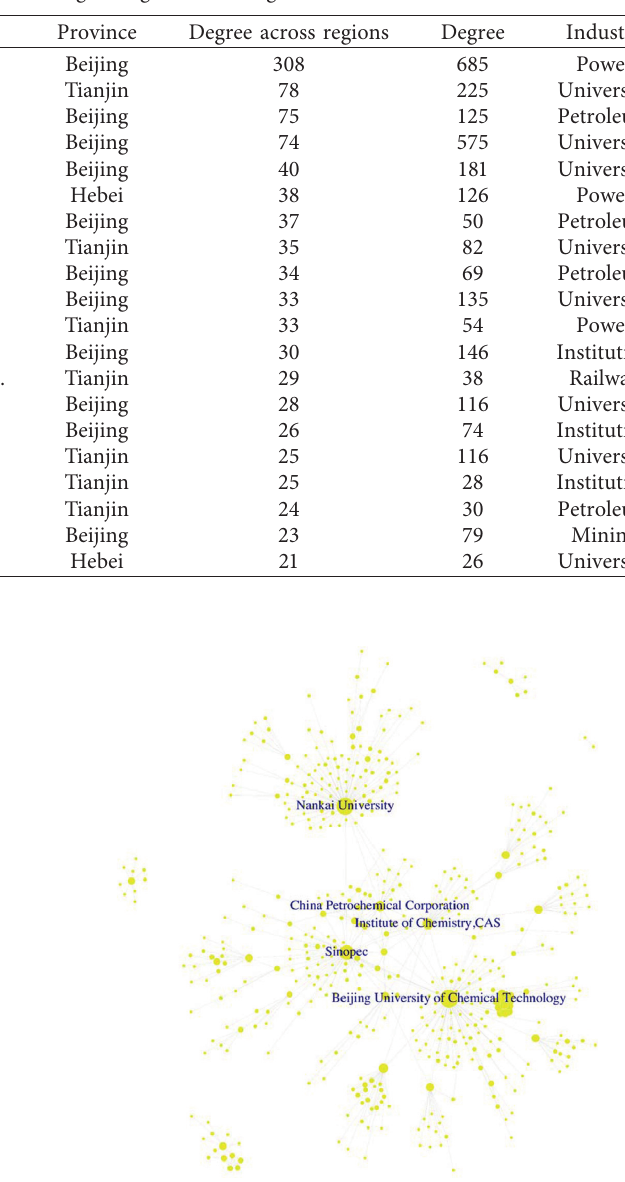
Figure 11: CNOOC community. Figure 12: Sinopec